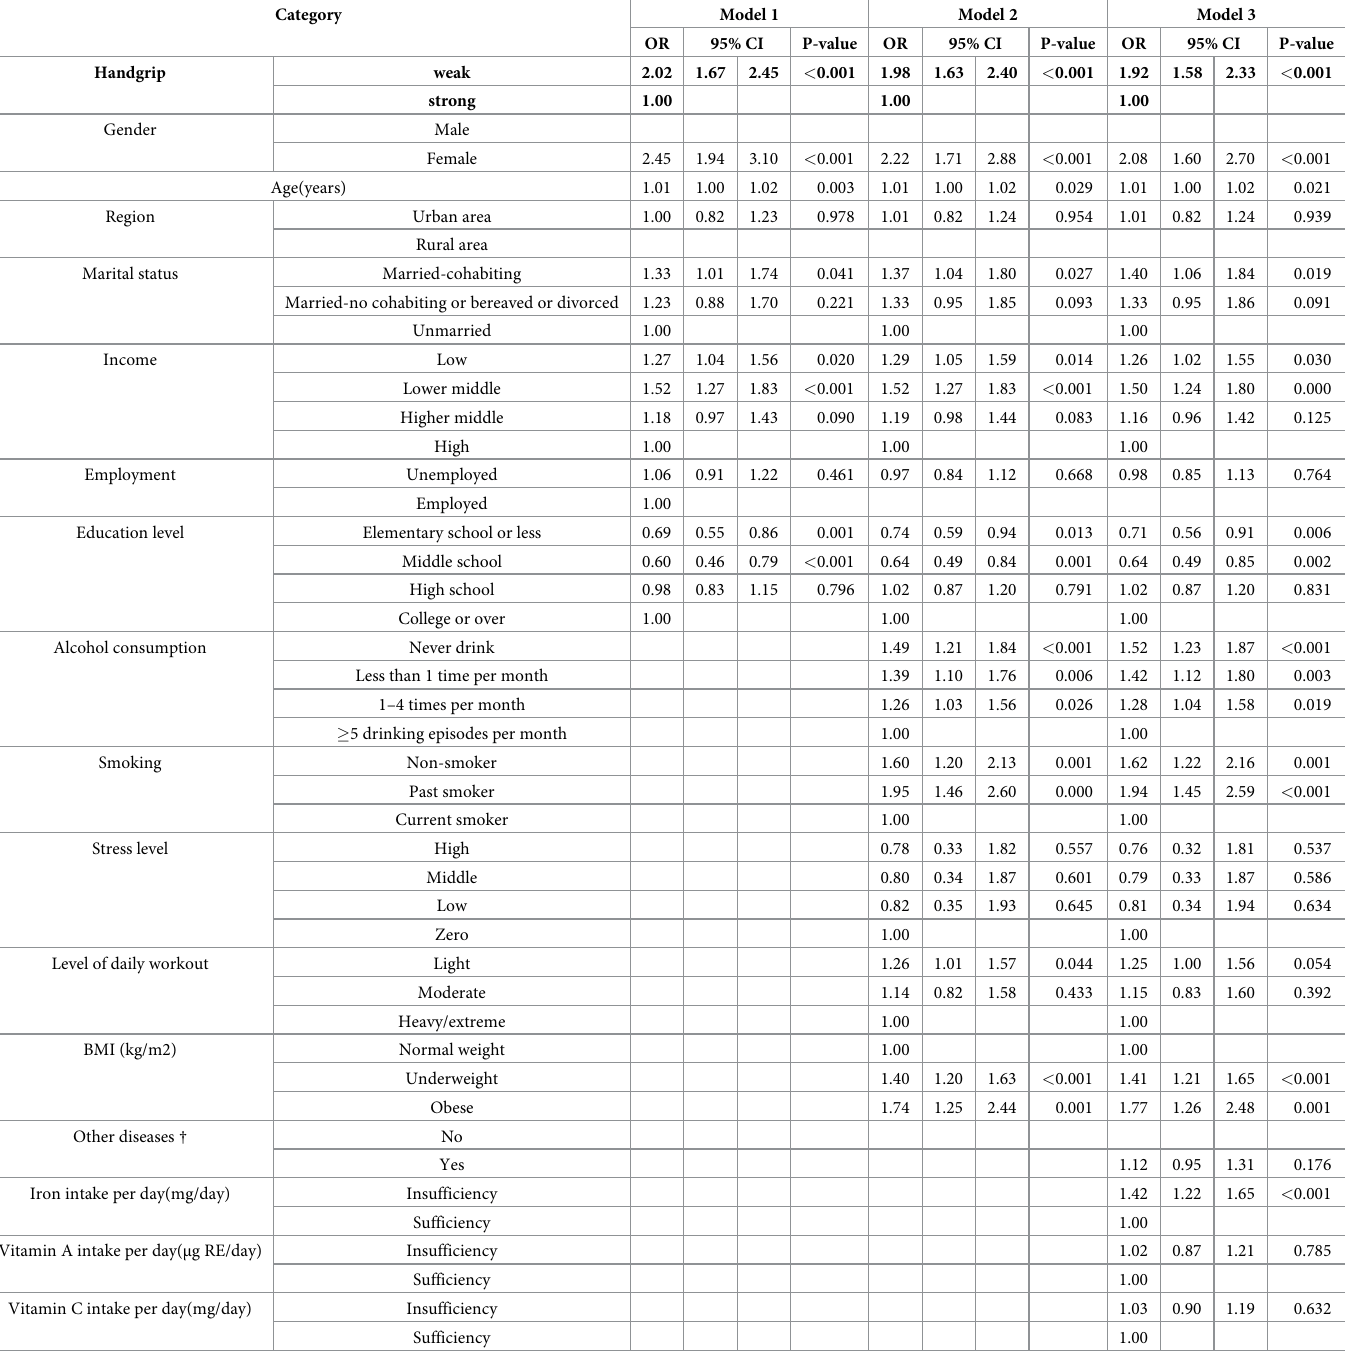
Table 4. Association between handgrip and